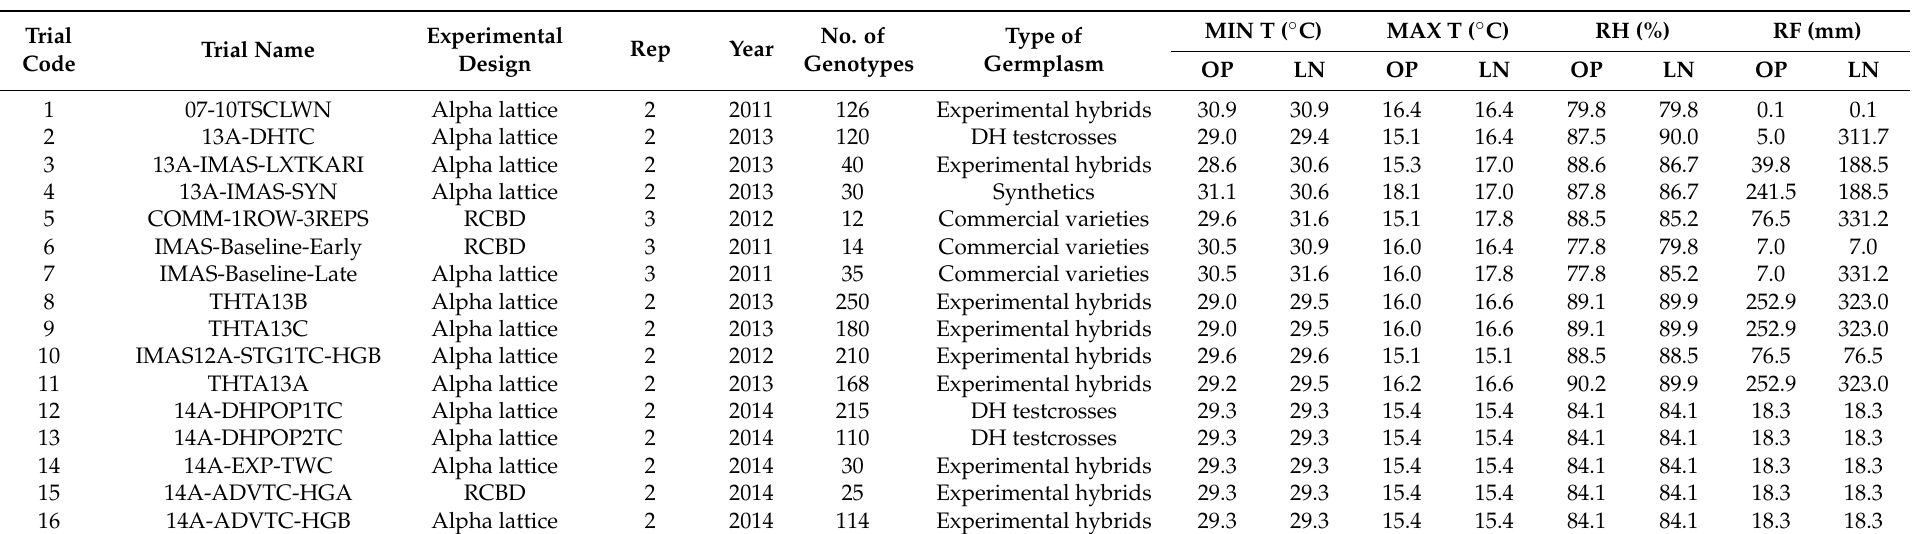
Table 1. Trial name, number of replications, design, number of genotypes tested and the average of weather parameters between planting and harvesting for each